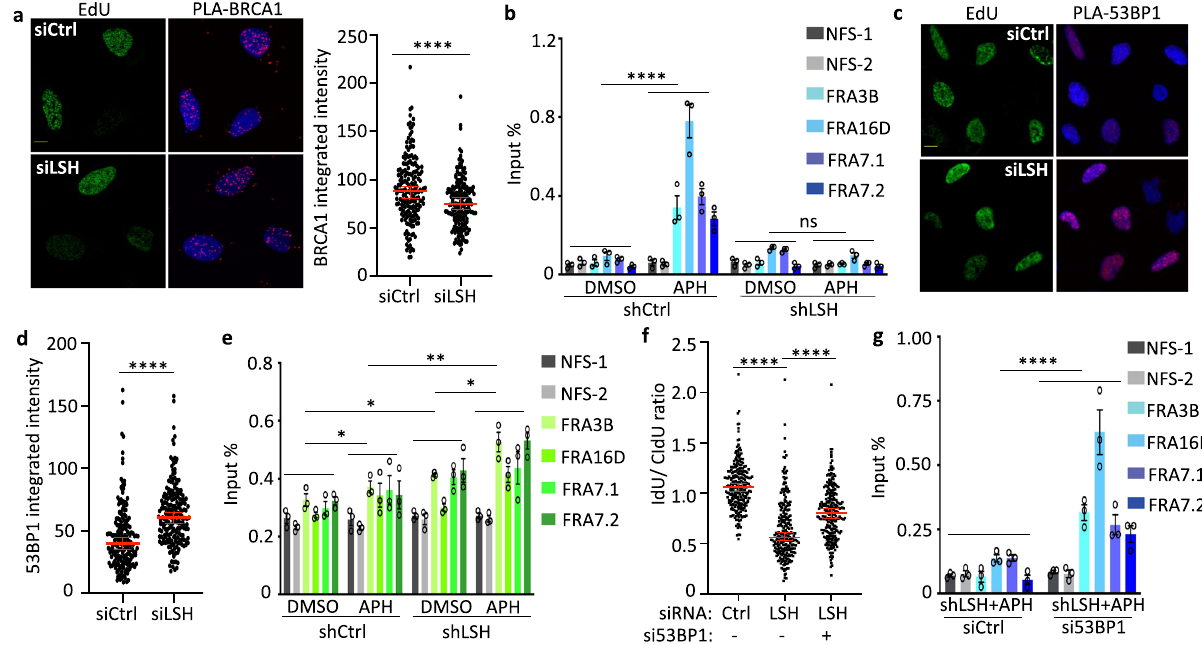
Fig. 6 Reduced BRCA1 and increased 53BP1 occupancy at stalled replication forks. a Representative images (left panel) and quanti fi cation of PLA signals (BRCA1: EdU) from U2OS cells transfected with the indicated siRNA after exposure to 4 mM HU for 5h. The scale bar represents 10 µ m. Quanti fi cation of PLA signals (BRCA1: EdU) is based on EdU-positive cells. Representative of n = 3 independent experiments. Data are represented as median± 95% CI ( n = 200 cells). **** p <0.0001 by two-tailed Mann – Whitney test. b ChIP-qPCR analysis for detection of BRCA1 enrichment at CFSs (FRA3B, FRA16D, FRA7.1, and represented as mean±SD ( n = 3 independent experiments). ns = not signi fi cant, **** p < 0.0001 by Student ’ s two-tailed t test. c Representative images of PLA signals (53BP1: EdU) from U2OS cells transfected with the indicated siRNA after exposure to 4 mM HU for 5h. The scale bar represents 10 µ m. d Quanti fi cation of PLA signals (53BP1: EdU) from U2OS cells as treated in Fig. 6C. Quanti fi cation of PLA signals (53BP1: EdU) is based on EdU-positive cells. Representative of n = 3 independent experiments. Data are represented as median± 95% CI ( n = 200 cells). **** p <0.0001 by two-tailed Mann – Whitney test. e ChIP-qPCR analysis for detection of 53BP1 enrichment at CFSs (FRA3B, FRA16D, FRA7.1, and FRA7.2) and control sites (NFS-1, NFS-2) in mock-treated (DMSO) or aphidicolin-treated (APH) U2OS cells transfected with shLSH or shCtrl. Data are represented as mean±SD ( n = 3 independent experiments). * p <0.05, ** p < 0.01 by Student ’ s two-tailed t test. f Nascent DNA degradation analysis after exposure to HU in U2OS cells transfected with siCtrl or siLSH or a combination of siLSH and si53BP1 leading to an intermediate 53BP1 depletion (0.3 in Supplementary Fig. 13B). The IdU/CldU ratio calculations are done as outlined in Fig. 2a. Representative of n = 3 independent experiments. Data are represented as median±95% CI ( n = 250 DNA fi bers). **** p value< 0.0001 by two-tailed Mann – Whitney test. g ChIP-qPCR analysis for detection of BRCA1 enrichment at indicated CFSs in aphidicolin treated (APH) U2OS cells transfected with shLSH and either siCtrl or si53BP1. Data are represented as mean ±SD ( n = 3 independent experiments). **** p < 0.01 by Student ’ s two-tailed t (Fig. 7d). ChIP analysis showed a small increase of H3K4me3 at CFS (Fig. 7e) and satellite repeats (Supplementary Fig. 16a) upon replication stalling in LSH-de fi cient cells compared with controls.